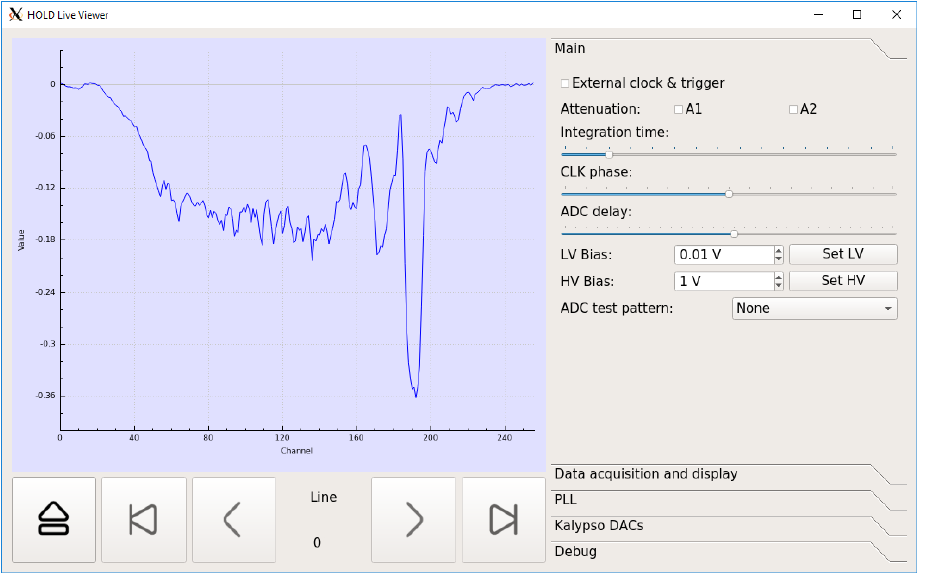
Figure 10. Live control and data acquisition application for